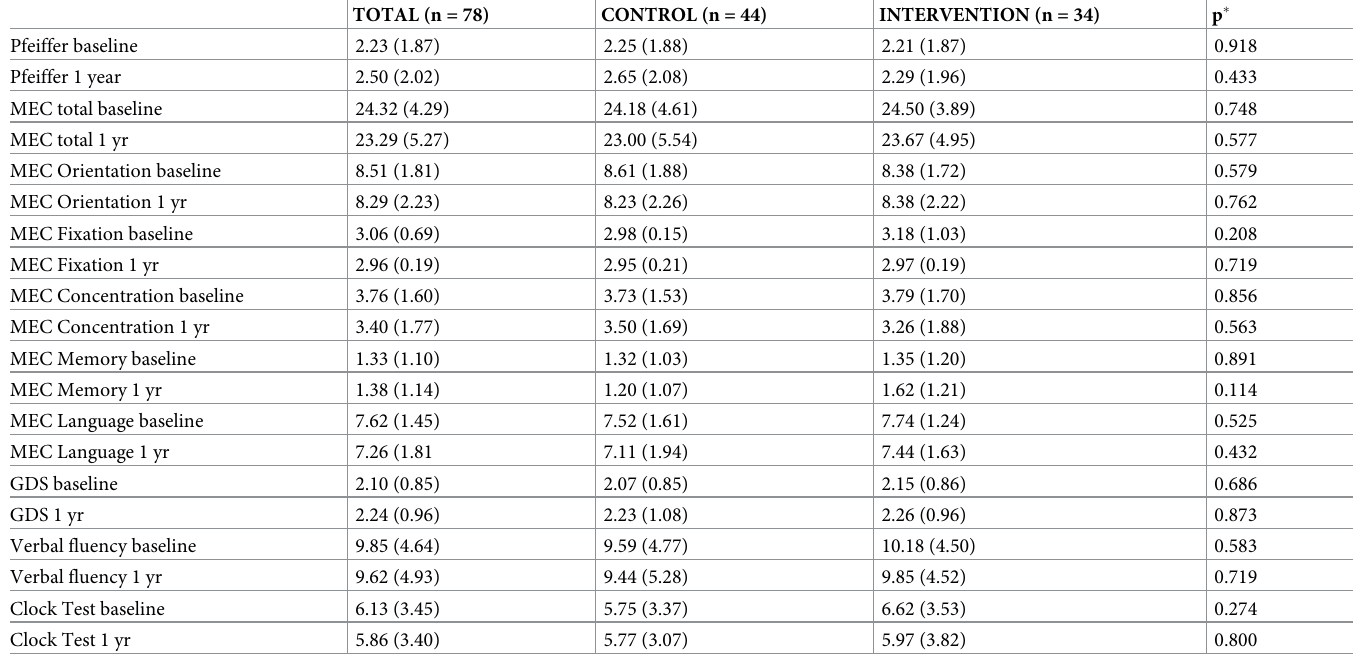
Table 2. Baseline and 1 year cognitive characteristics of the participants according to the study